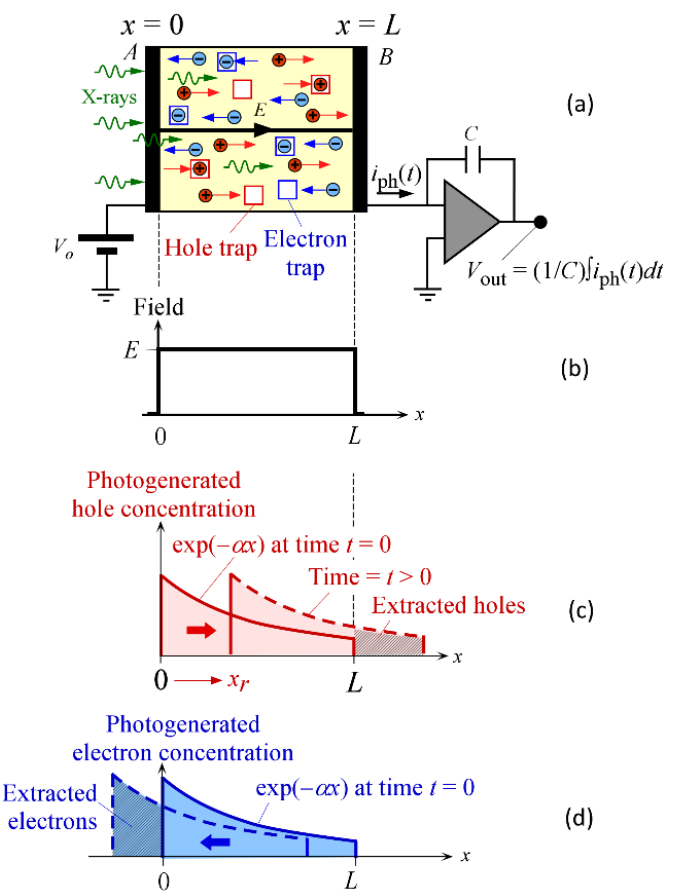
Figure 7. ( a ) A high ‐ resistivity semiconductor used in an integrating detector. The incident radiation (X ‐ rays) photogenerates electrons and holes which drift. Some of the carriers are captured in deep traps. ( b ) The field is assumed to be uniform. ( c ) The hole photogeneration profile at t = 0 and some time later. ( d ) The electron photogeneration profile at t = 0 and some time later.